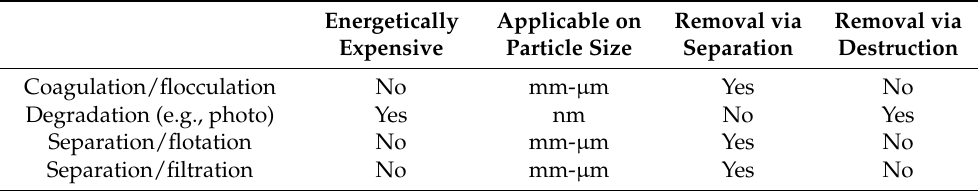
Table 1. Groups of methods applicable on microplastics removal.